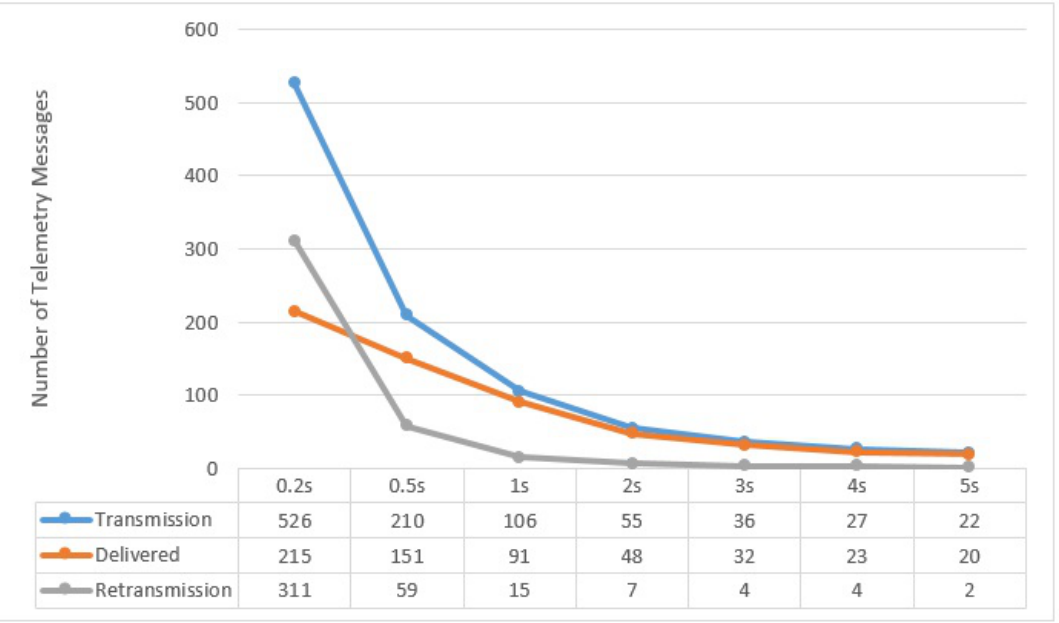
Figure 15. UAV to BS Communication at 15 m/s with respect to different Flush Back Periods.